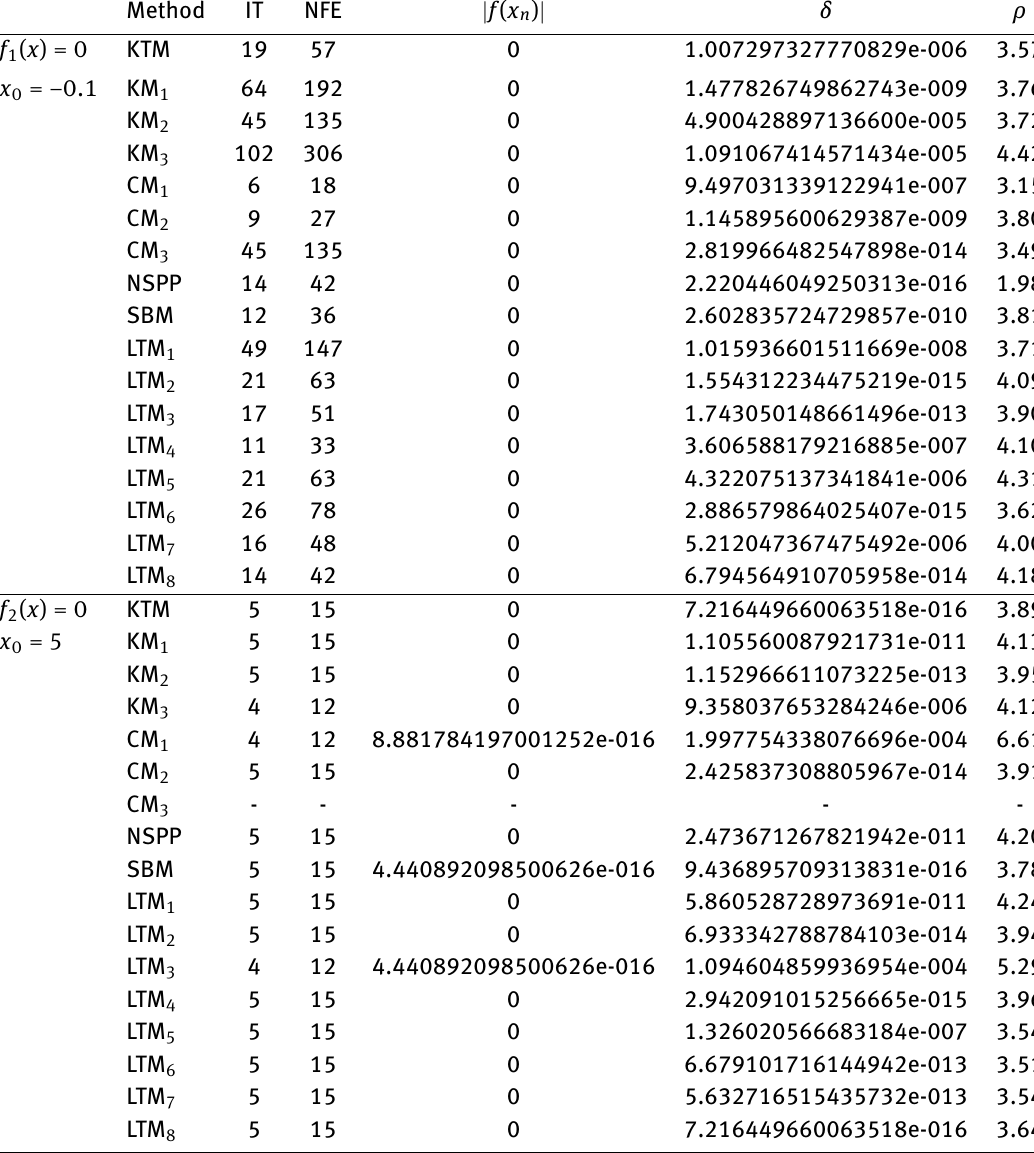
Table 3: Comparison of some different fourth-order